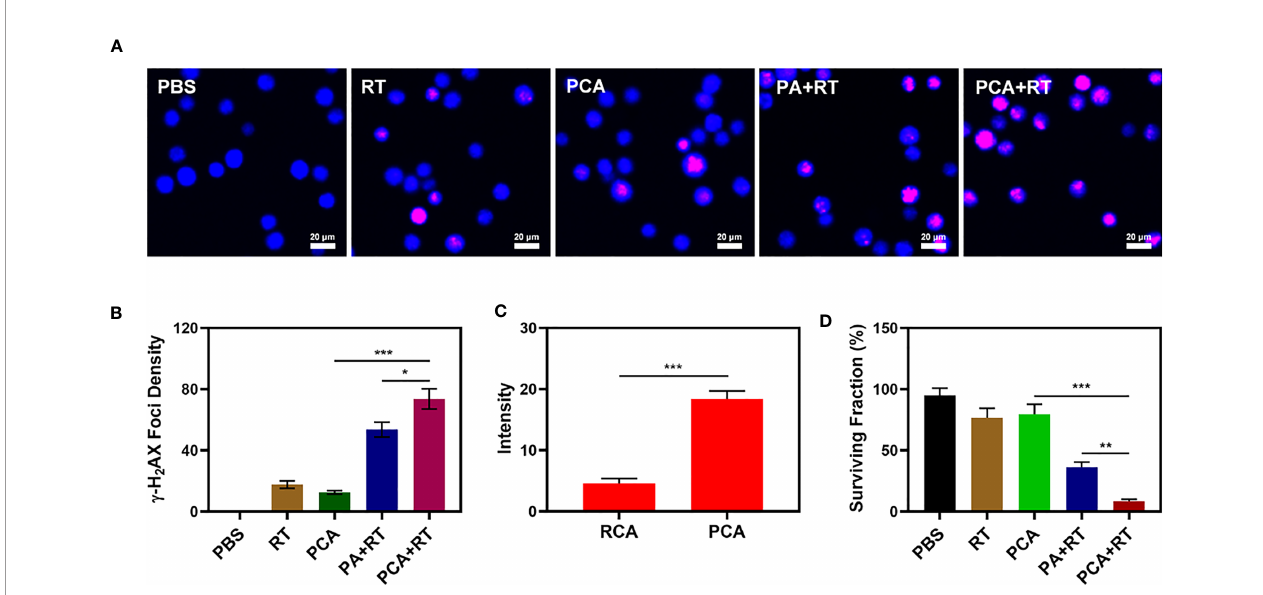
FIGURE 2 | The CLSM images of 4T1 cells with different treatments. The nuclei were stained with DAPI (blue) and DSBs were stained with g -H 2 AX (red). (B) Average fl uorescence intensity of g -H 2 AX from fi gure (A) . (C) Co-localization of Lyso-Tracker Green FM (blue) and Dil (red) for RCA and PCA over time in 4T1 tumor cells. (D) Colony formation assays were conducted using 4T1 cells treated with 2 Gy of radiation (n = 3). Signi fi cant differences among groups as calculated using the Student ’ s t-test. *P < 0.05, **P < 0.01, ***P <